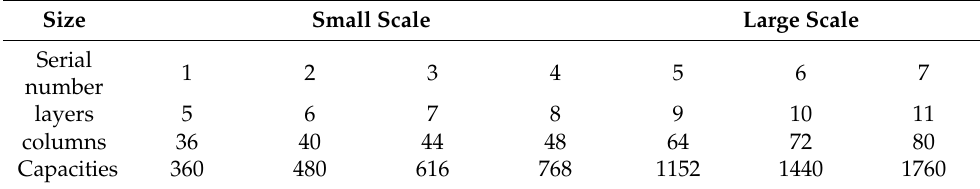
Table 5. Simulation scale.